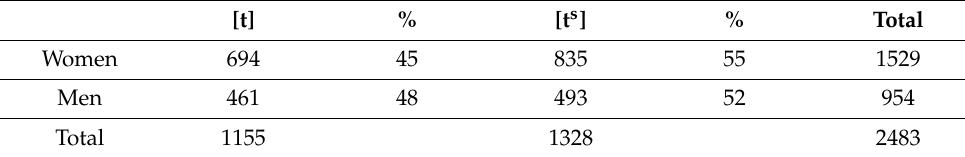
Table 3. Gender distribution of dental variants.